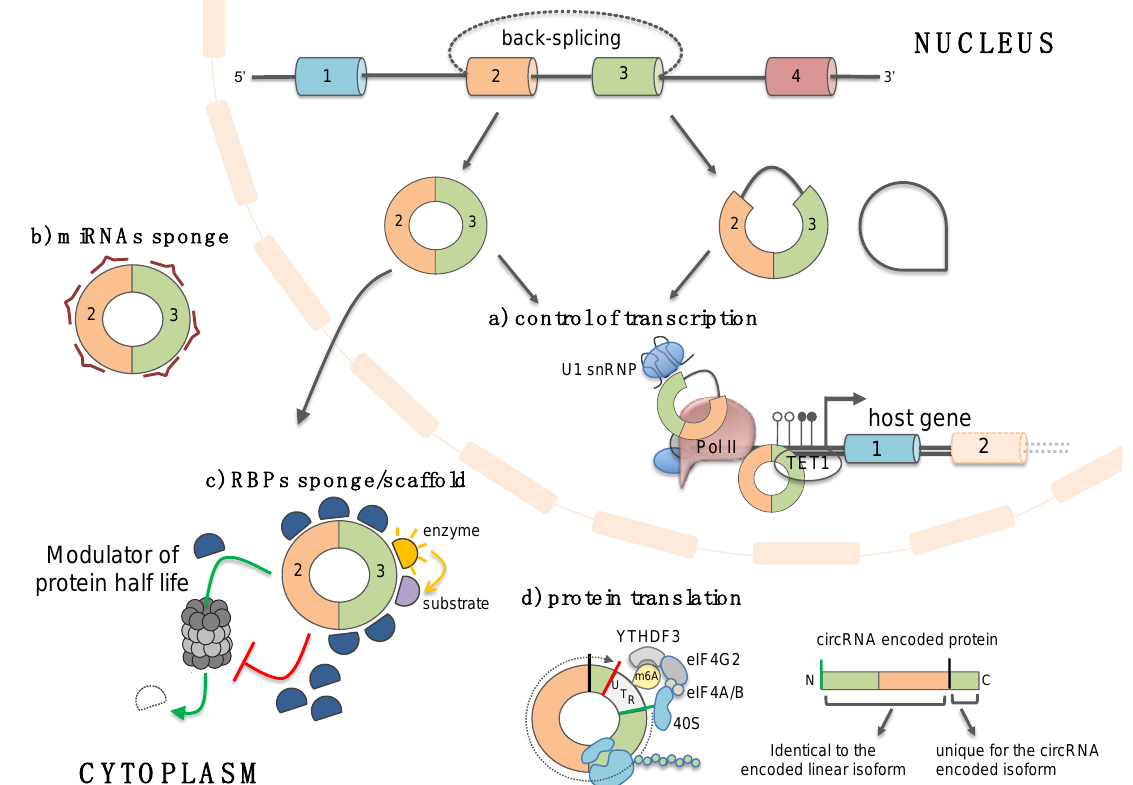
Figure 3. CircRNA functions. CircRNAs localized in the nucleus can function as a modulator of transcription of their host genes either by interacting with U1 small nuclear ribonucleoprotein (U1 snRNP) and enhancing the function of RNA polymerase II (Pol II) complex or by recruiting methylcytosine dioxygenase TET1 to the promoter region ( a ). When exported into the cytoplasm circRNAs can function as sponges or decoys for microRNAs and RBPs or alternatively can modulate the half-life of specific RBPs counteracting (red T line) or favoring their proteasome mediated degradation (green arrow) ( b , c ). CircRNAs have been shown to function also as protein scaffolds ( c ). By facilitating the colocalization of enzymes and their substrates are able to enhance the reaction kinetics (yellow arrow). Finally, circRNAs with internal ribosome entry site (IRES) elements and AUG sites (green line) may be translated through a CAP-independent mechanism (dashed arrow; red line depicts the STOP codon). This latter is promoted by the presence of methyl adenosine (m6A) and by the involvement of the reader protein YTHDF3 and the IRES-specialized translation initiation factor eIF4G2 ( d ). The protein isoform produced from circRNA translation will have part of the primary sequence in common with the linear encoded protein, while the rest of the polypeptide is unique for the circRNA encoded isoform.